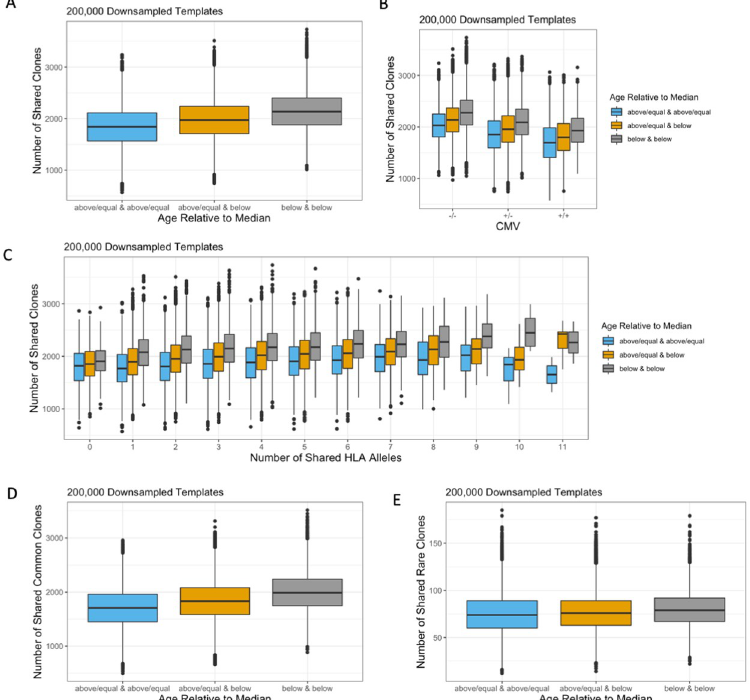
Fig 5. Impact of age on TCR β clone sharing. Individuals were stratified by the median age (42). (A) Younger individuals shared more clones in their down-sampled repertoires compared to older individuals, independent of (B) CMV exposure and (C) shared HLA alleles. Among (D) common and (E) rare clones, younger individuals shared more clones in their down-sampled repertoires than older individuals.